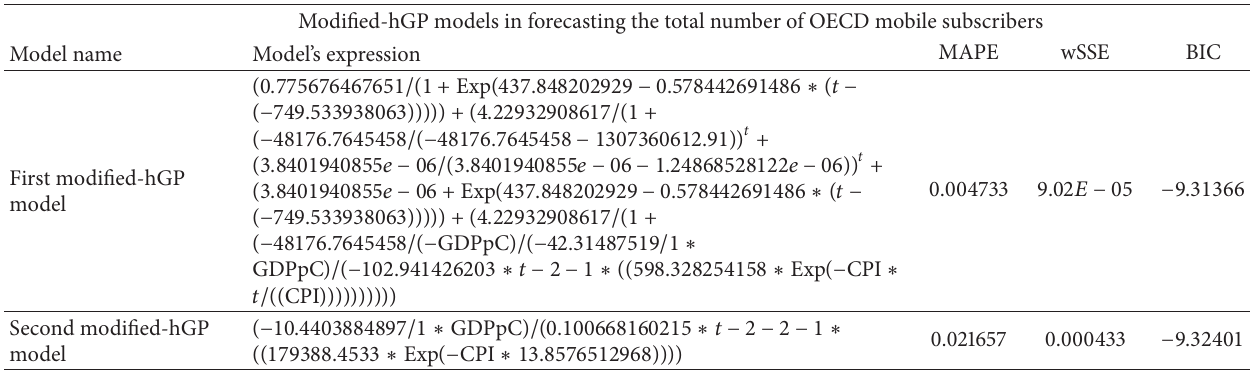
Table 16: Models’ expression and statistical indices of two modified-hGP models in forecasting the total number of OECD subscribers. Modified-hGP models in forecasting the total number of OECD mobile